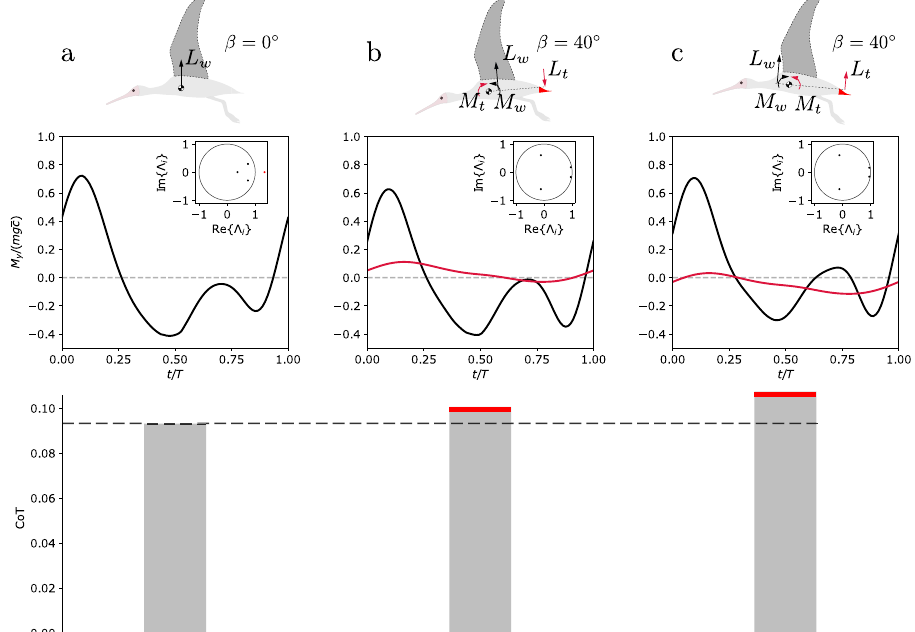
Figure 4. Characterization of three representative limit cycles: one with furled tail ( a ), and two with a tail opened with an angle β = 40 ◦ ( b , c ). The upper panel represents the free-body diagram of the three different flight configurations. Case (a): The pitching moment is only due to the wing movement, and averages at zero. This flight regime is characterized by an unstable mode, highlighted by an eigenvalue larger than 1 (inset middle panel). The bottom panel gives the CoT for this flight configuration. Case (b): The average pitching moment M w due to the wing lift ( L w ) is negative (nose down) and the average moment due to the tail lift, M t , is positive (nose up). This solution is stable as all the eigenvalues are smaller than 1 in absolute value (inset middle panel). The CoT is quantified in the bottom panel, and with the contribution due to dissipative forces acting on the tail being highlighted in red. Case (c): The average pitching moment due to the wing lift ( L w ) is positive (nose up) and the average moment due to the tail lift is negative (nose down). This solution is also stable as all the eigenvalues are smaller than 1 in absolute value (inset middle